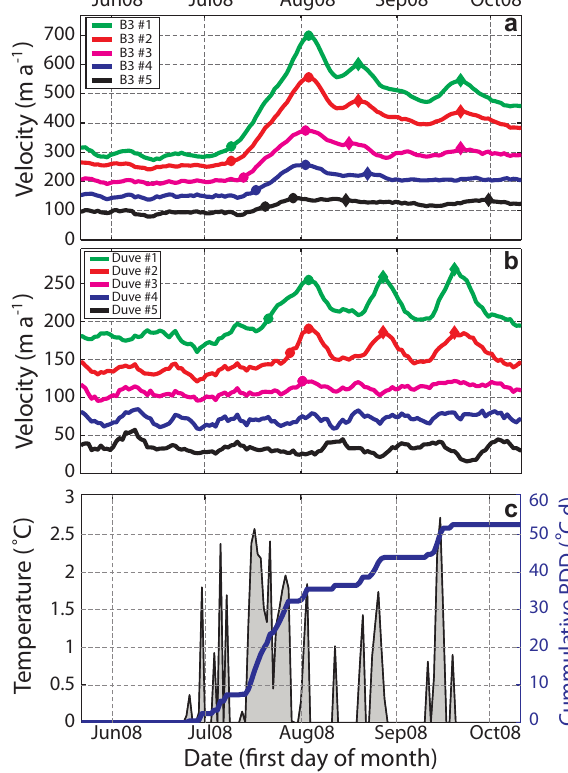
Fig. 5. Summer speed-up along the central flowline of Basin-3 (a) and Duvebreen (b) in summer 2008. Markers indicate the occur- rence of the onset of summer speed-up and three separate velocity peaks (see also Table 3). Positive daily mean air temperature and cumulative PDD at the AWS on Etonbreen is shown in (c) .